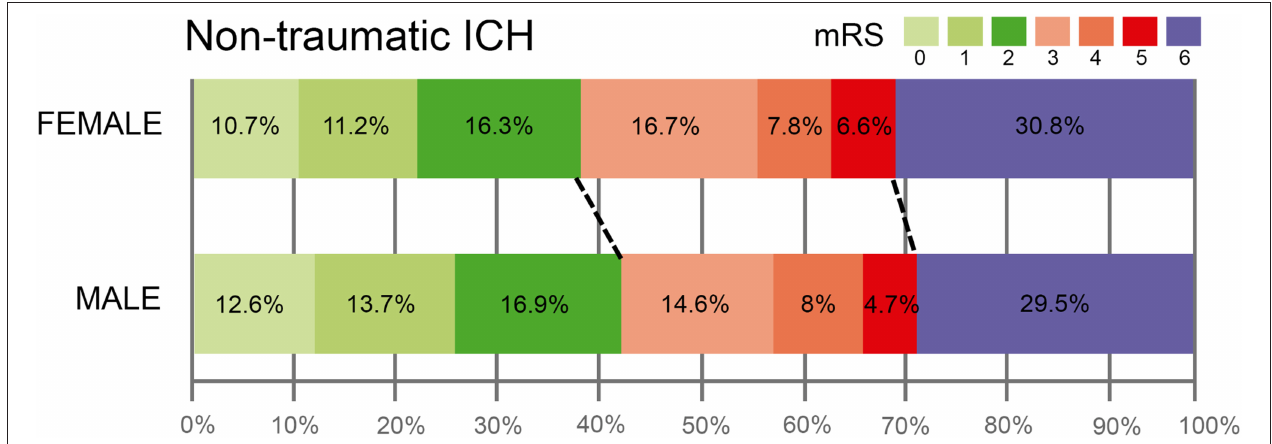
FIGURE 4 | Distribution of the modified Rankin Scale (mRS) scores in ICH patients categorized by sex.